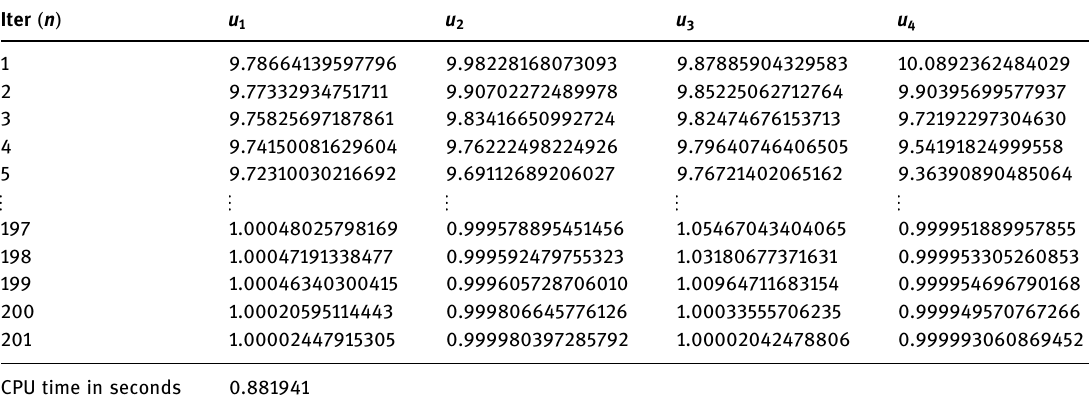
Table 5: Example 4.2: Numerical study of Algorithm 1 in [ 30 ] and